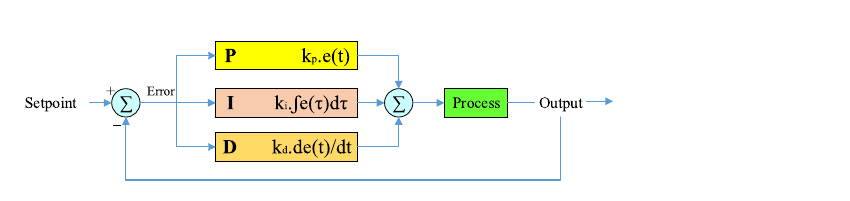
Figure 3. PID controller